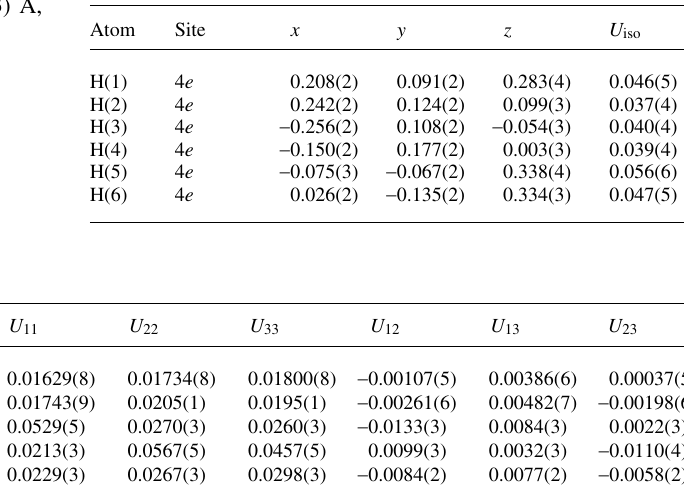
Table 2. Atomic coordinates and displacement parameters (in Å 2 ) .